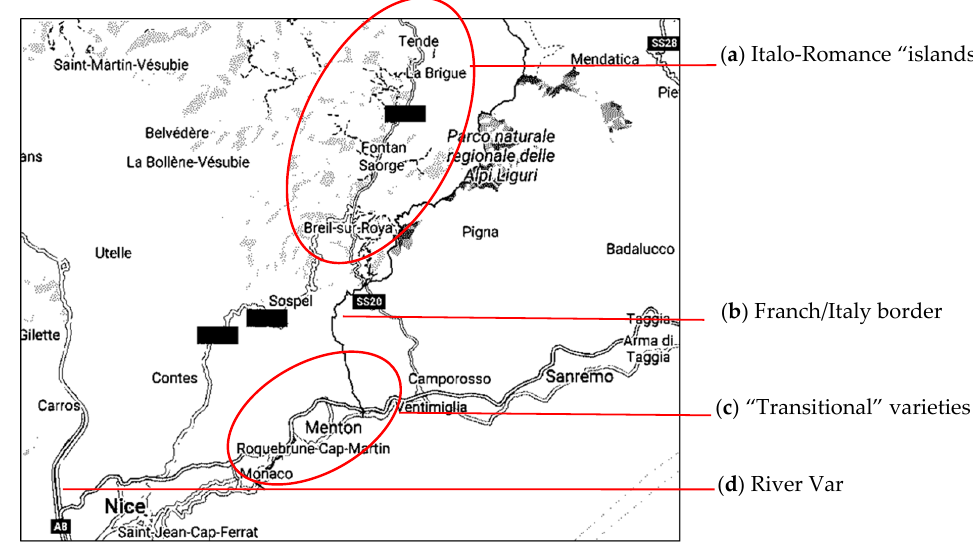
Figure 1. Contact area between southern Occitan and (Intemelian) Ligurian. Source: Google Maps. The dialects spoken in this area belong to two Romance subgroups: southern Occitan (Sauzet and Oliviéri 2016) and Intemelian Ligurian (Forner 1986). The linguistic boundary between Occitan and Italo-Romance, unlike the one between Italian and French, runs nowadays through French territory (Figure 1b; see Dalbera 2003): Italo-Romance dialects are still spoken in the French villages of Saorge, Breil-sur-Roya, Fontan, Brigue, and Tende (see Figure 1a). Conversely, no Occitan dialect is spoken in Liguria, although few municipalities at the border claim their dialect is Occitan. From a sociolinguistic standpoint, Italian speakers tend to be diglossic (Italian/dialect), whereas French speakers tend to be monolingual. Occitan varieties and the Ligurian dialects in French territory are, in fact, highly endangered.